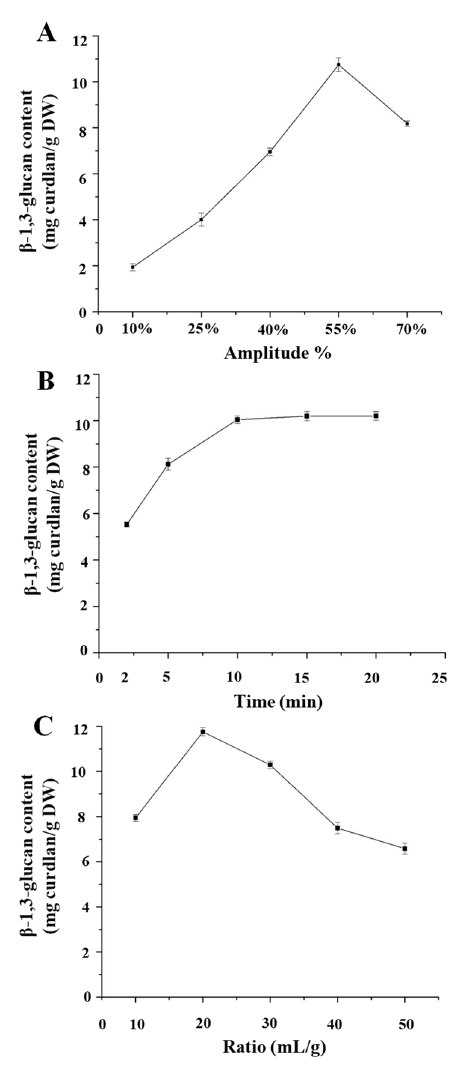
Figure 3. Effects of ( A ) ultrasound amplitude, ( B ) ultrasound extraction time, and ( C ) ratio of water to raw material on the extraction yield of water soluble 1,3- β -glucans. All experiments were conducted in triplicate, and data are expressed in means ± standard deviations. The error bars are standard deviations.